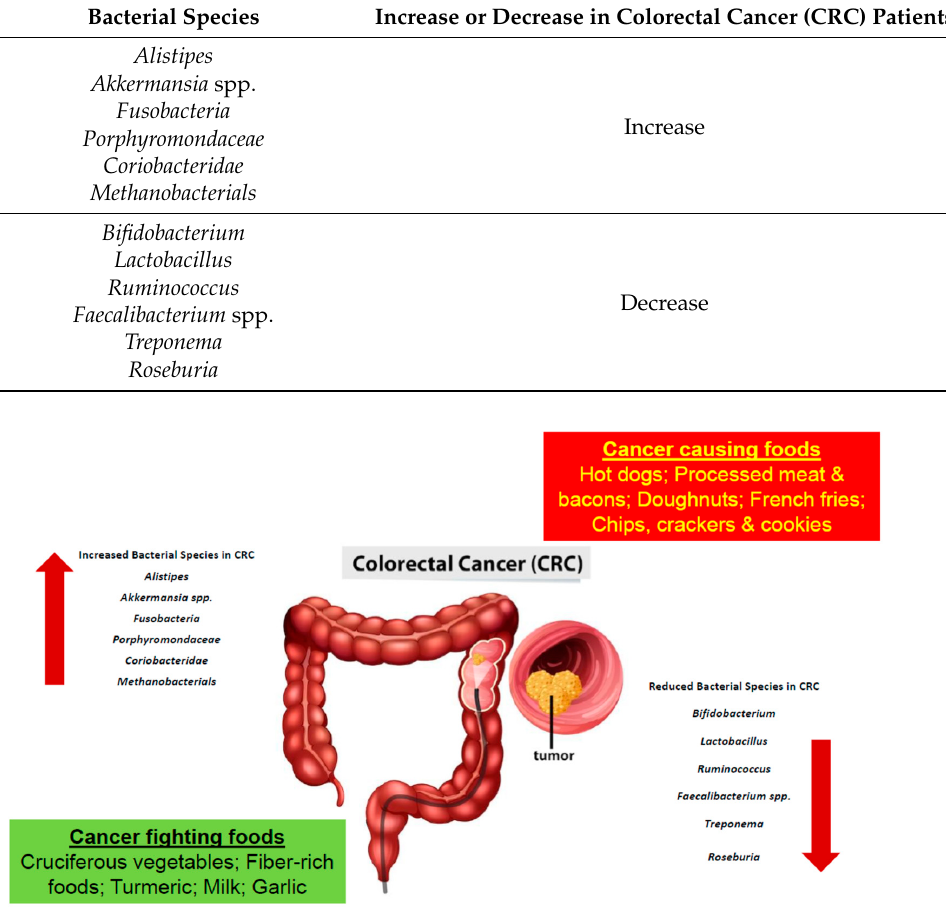
Figure 1. The development of colorectal cancer is a result of a multifactorial process involving the consumption of various foods and gut microbial dysbiosis. consumption of various foods and gut microbial